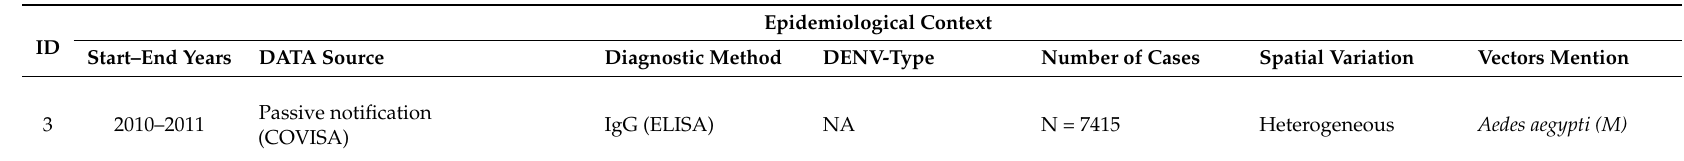
Table 2. Structuring of the data extracted from the articles on the epidemiological context. First line (id: 3) is given as an example. Please refer to the annex-table 2 for the whole dataset ([n = 78] articles). In last column, we indicate if vectors are only mentioned (M) or observed (O) in the study.